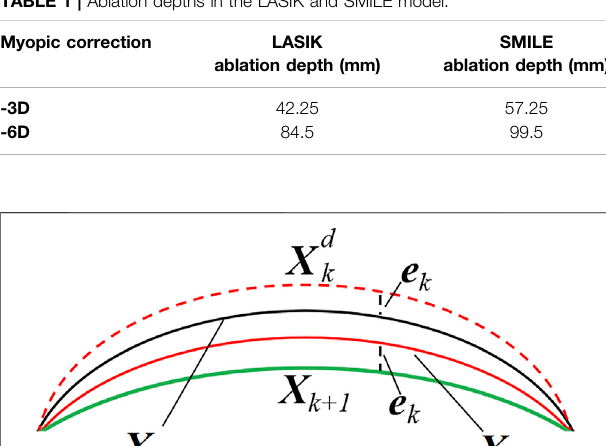
TABLE 1 | Ablation depths in the LASIK and SMILE model.